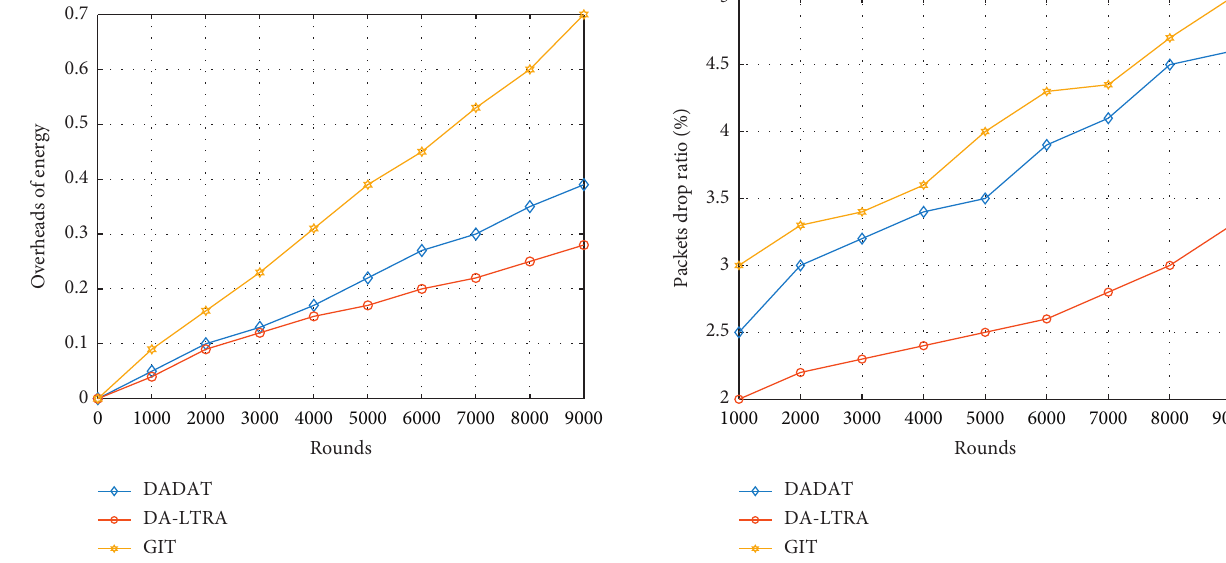
Figure 15: Packets drop ratio under different